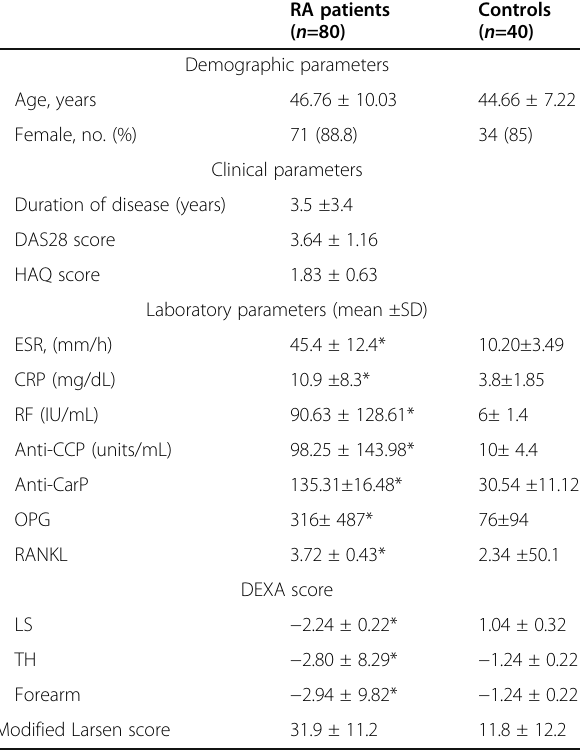
Table 1 Demographic data of the two studied groups: Showing significant increase in all laboratory findings and Larsen score and significant decrease in DEXA score in rheumatoid patients as compared with controls by using t test